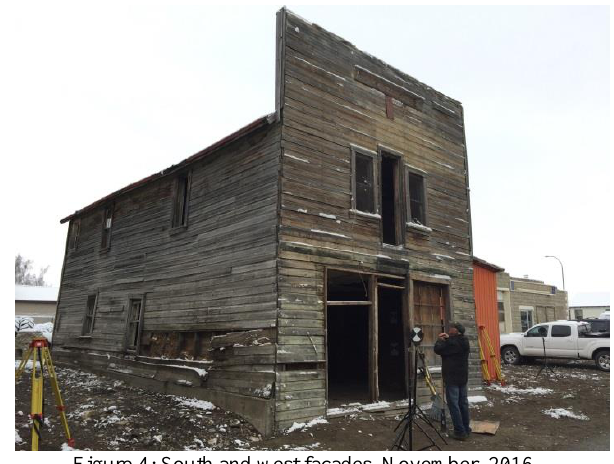
Figure 4: South and west facades. November, 2016.